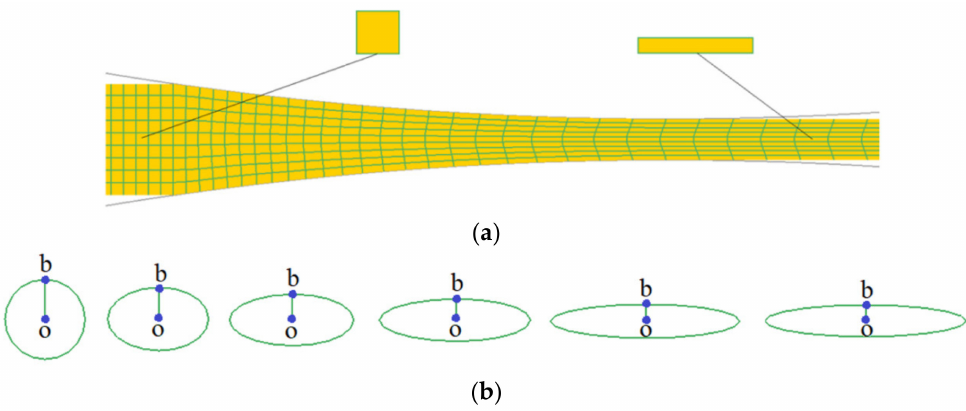
Figure 20. FEM simulation (this work) of pure shear during symmetric rolling ( a ) and transformation of strain ellipsoid (in the middle layer) when passing through the deformation zone ( b ). Simple shear corresponds to equal channel angular pressing (ECAP) (Figure